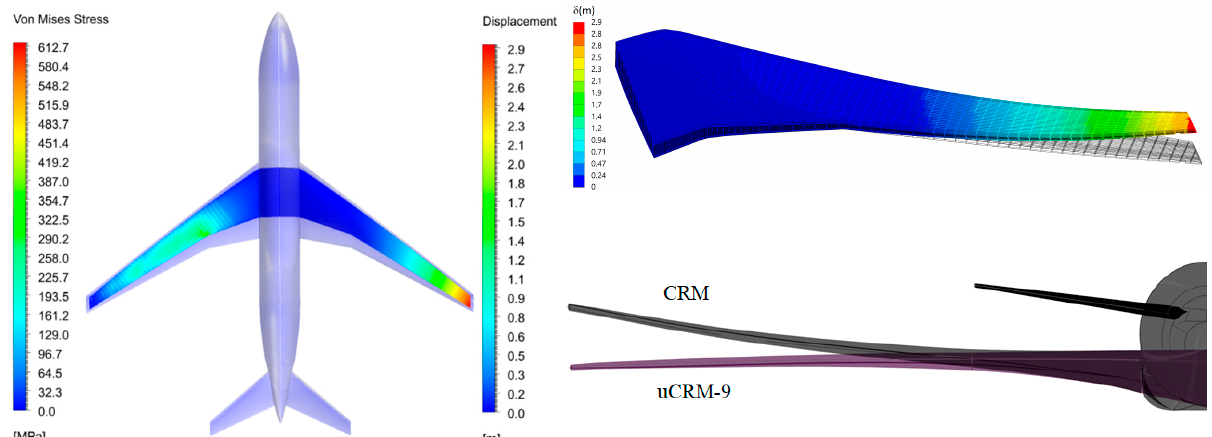
Figure 10. CRM aircraft in flight condition S 2 (M = 0.85 at 37,000 ft) with an angle-of-attack α = 2.25 ◦ .